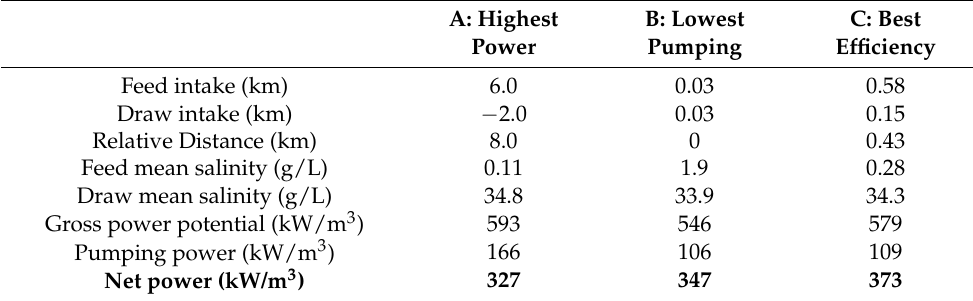
Table 3. Comparison between relevant combinations of feed and draw locations.